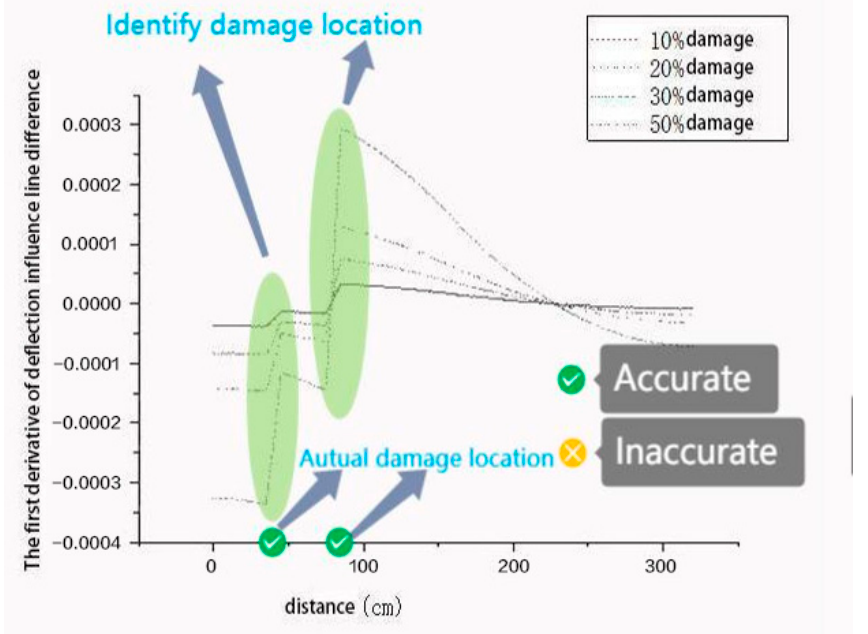
Figure 21. The 1st derivative of deflection influence line difference at 3/4 determining points of the first span under work condition 2 (2-5).